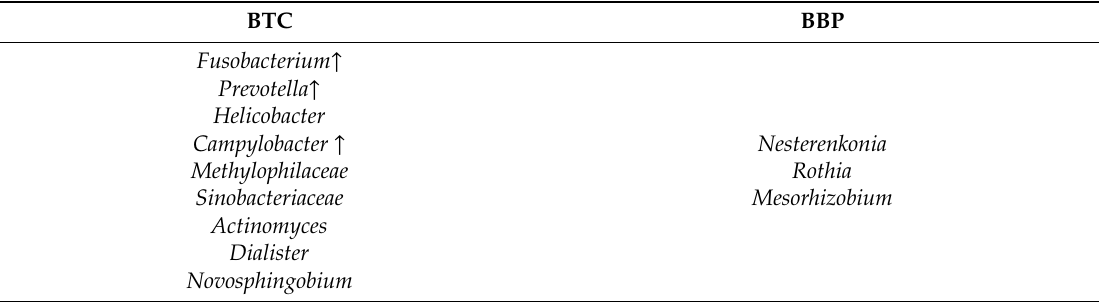
Table 6. Di ff erences in most abundant bacteria species in bile tract microbiota composition isolated from biliary tract cancer (BTC) patients and patients with benign biliary pathology (BBP) (distribution of clones at the genus